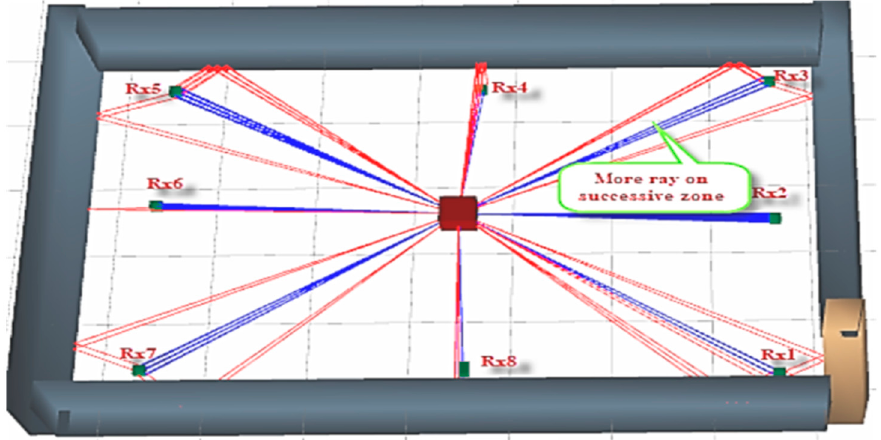
Figure 4. Ray tracing simulation using the proposed method.